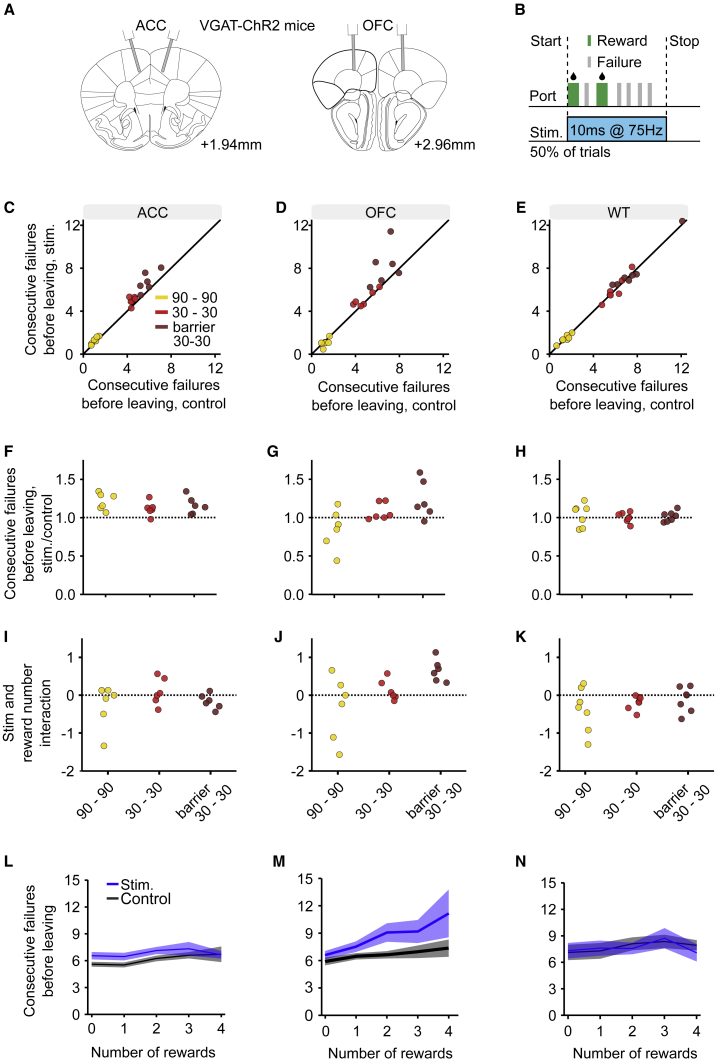
OFC, but Not ACC, Is Necessary for Optimal Inference(A) Scheme of the optic fiber placement.(B) Bilateral photostimulation at 3 mW happened during nose-poking: it was triggered by the first poke in 50% of trials and lasted for 500 ms after the last poke in the trial.(C–E) Consecutive failures before leaving split by environment statistics, barrier condition, and subject inactivation versus control trials, for ACC implanted heterozygotes (C), OFC implanted heterozygotes (D), and wild-types (E), respectively.(F–H) Ratio of consecutive failures before leaving split in the same way as (C)–(E) for ACC implanted heterozygotes (F), OFC implanted heterozygotes (G), and wild-types (H), respectively. When predicting renormalized consecutive failures, Stimulation and Protocol interact for OFC implanted heterozygotes (p < 1e−10, n = 6 mice) but not for ACC implanted heterozygotes (p = 0.15, n = 6 mice) or wild-types (p = 0.77, n = 7 mice).(I–K) An animal by animal quantification: the coefficient of the interaction term in ConsecutiveFailures∼1+Stimulation+Rewardnumber+Rewardnumber&Stimulation for ACC implanted heterozygotes (I), OFC implanted heterozygotes (J), and wild-types (K).(L–N) Number of consecutive failures as a function of reward number in the 30-30 barrier protocol for ACC implanted heterozygotes (L), OFC implanted heterozygotes (M), and wild-types (N). Solid lines and shaded areas represent mean and SEM across animals.See also Figure S2 and Table S1.